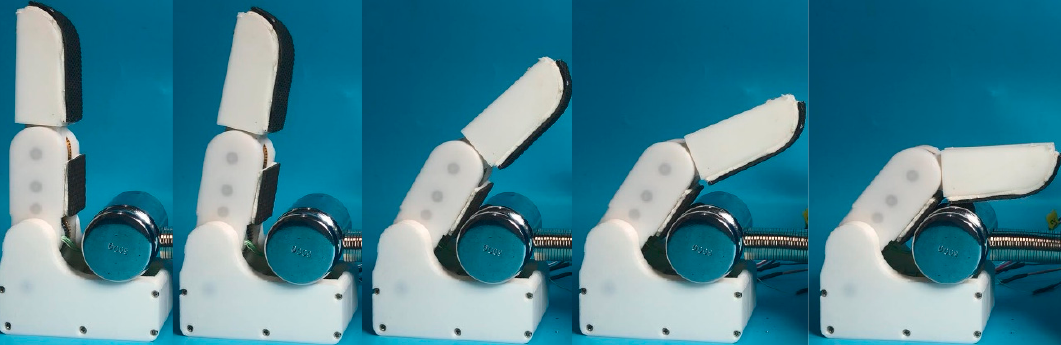
Figure 21. Motion process of the COSA mode.